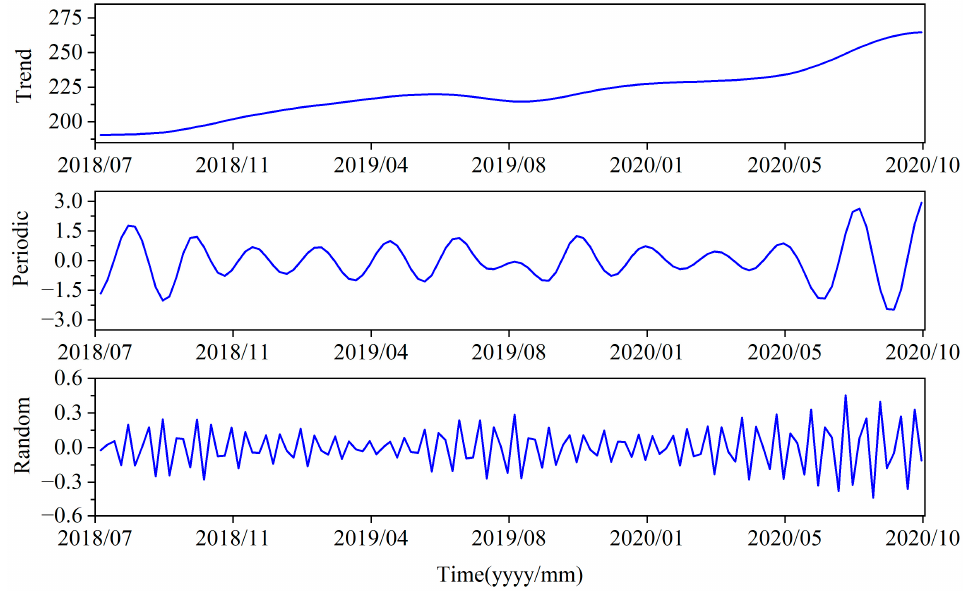
Figure 6. Decomposition results of the displacement data after